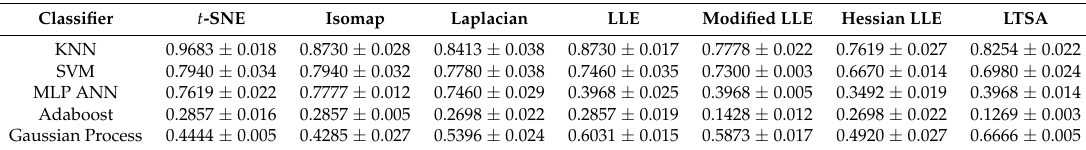
Table 4. Accuracy average and standard deviation of classification accuracies, values obtained after performing n = 10 experiments. Varying the classifiers with respect to the manifold learning algorithms. The number of target dimensions was equal to